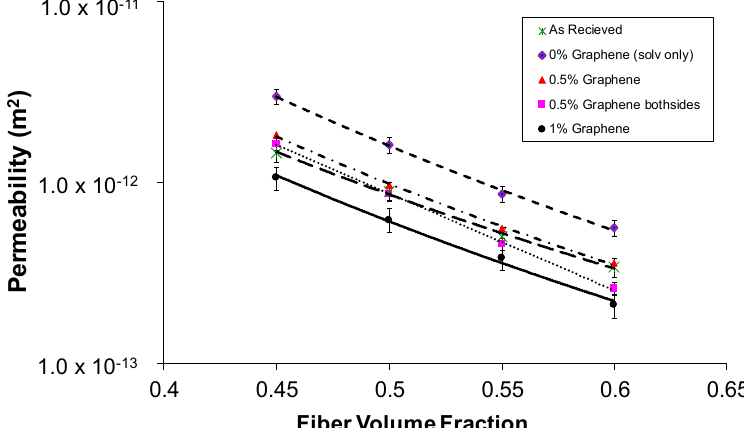
Figure 7. Transverse permeability results of different percentages of graphene coated glass fiber reinforcement.